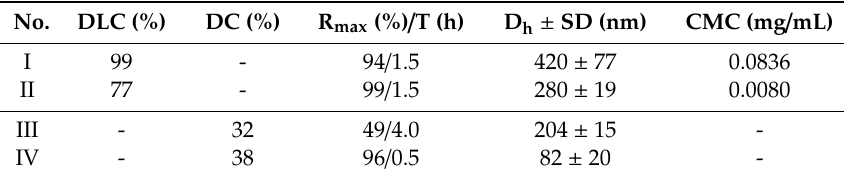
Figure 2. Preliminary biological evaluation of the potential for using carriers in cosmetic products.